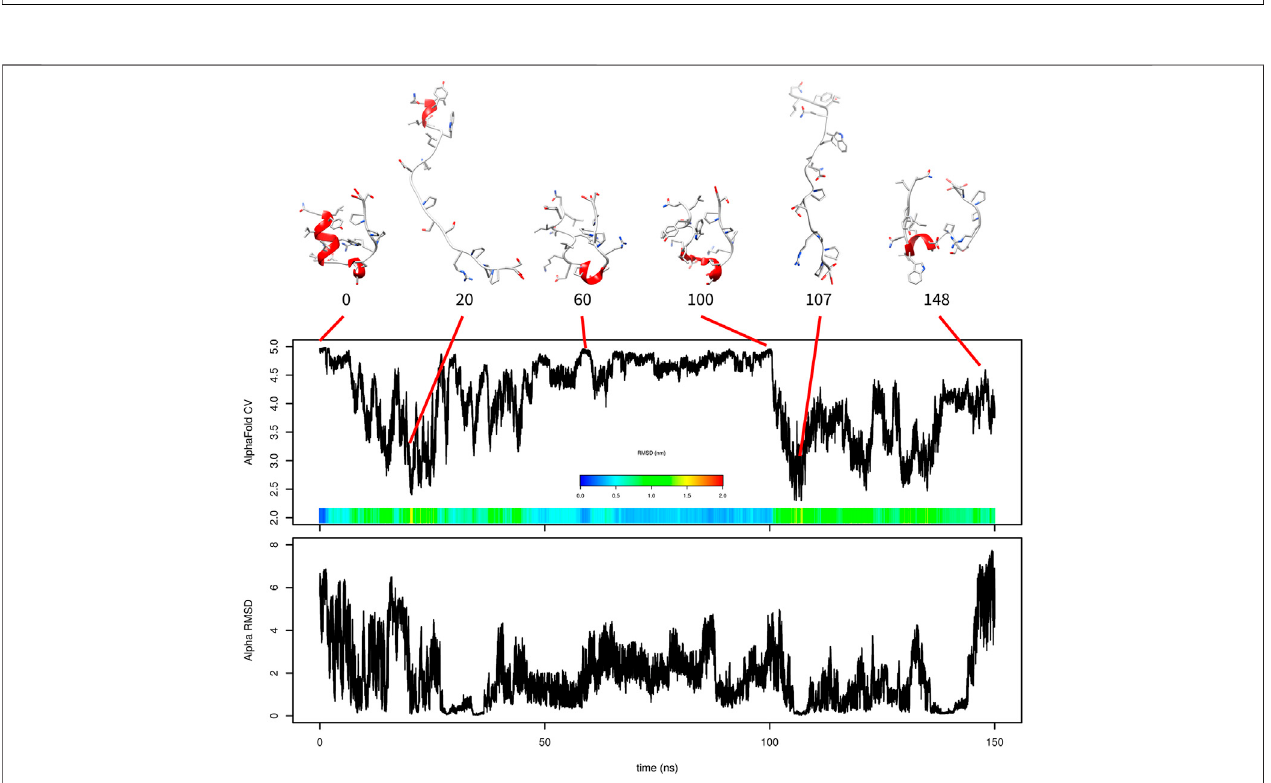
FIGURE 3 | Evolution of AlphaFold-based CV and α -RMSD in metadynamics simulation of Trp-cage with both CVs with selected frames. RMSD is depicted in the color scale.